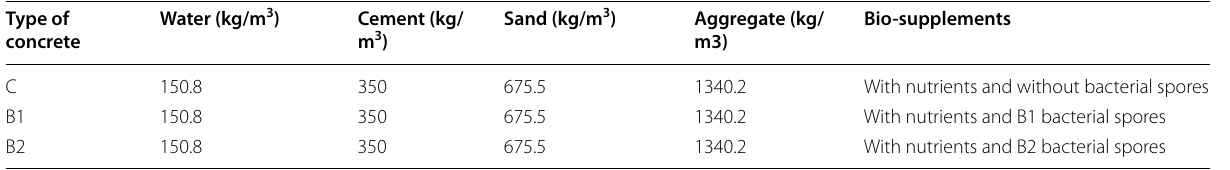
C, With nutrients and without bacterial spores (control); B1, With nutrients and B1 bacterial spores; B2, With nutrients and B2 bacterial spores